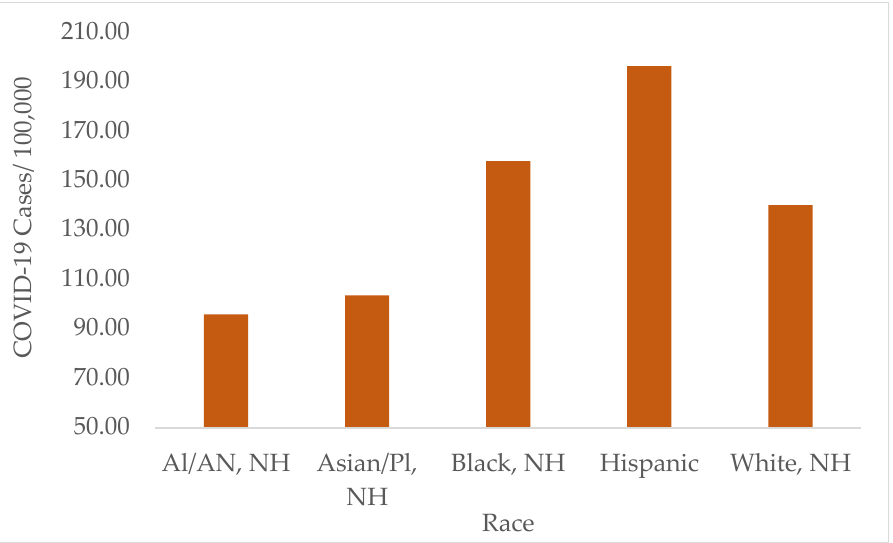
Figure 8. Average number of COVID-19 cases by race in all states from 2020 to 2022. The highest number of COVID-19 cases was observed in the Hispanic population, followed by the Black/African American population ( p < 0.001). Note: AI: American Indian, AN: Alaska Native, NH: Non-Hispanic, Pl: Pacific Islander.